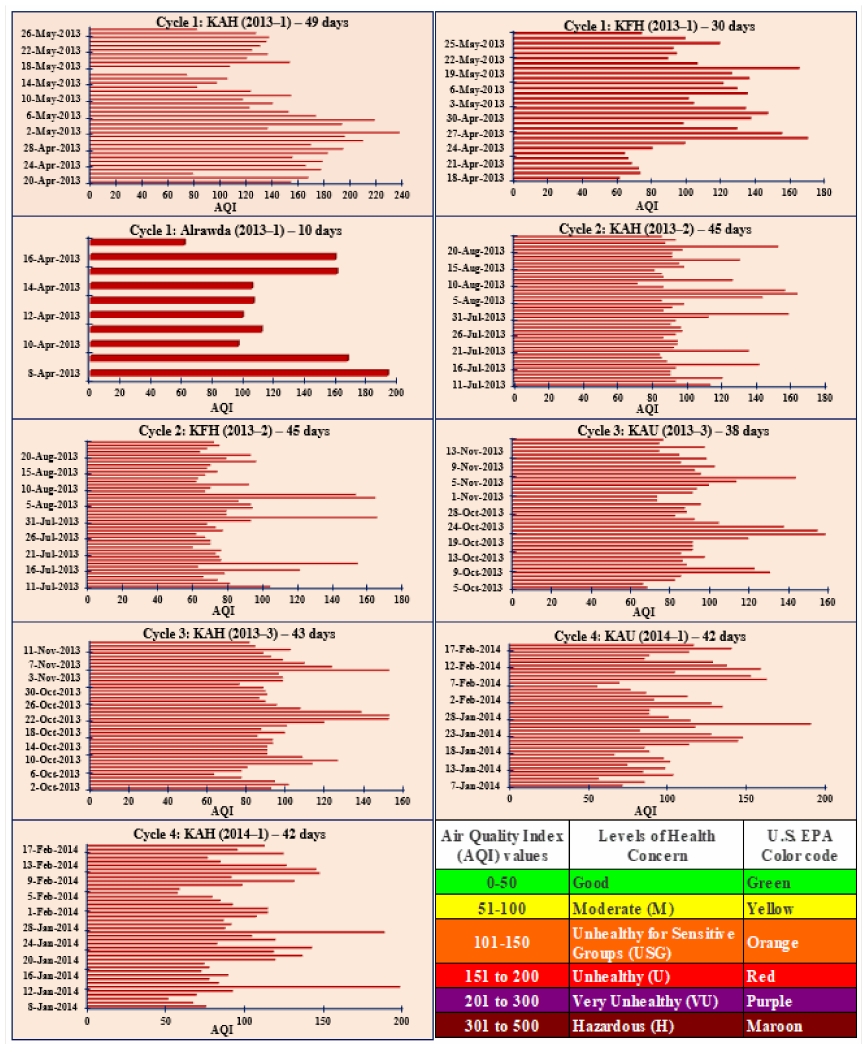
Figure 3. Bar graphs showing the Air Quality Index for PM 2.5 measured in Jeddah. AQI computations are based on the provisions of the United Sates Environmental Protection Agency (U.S.